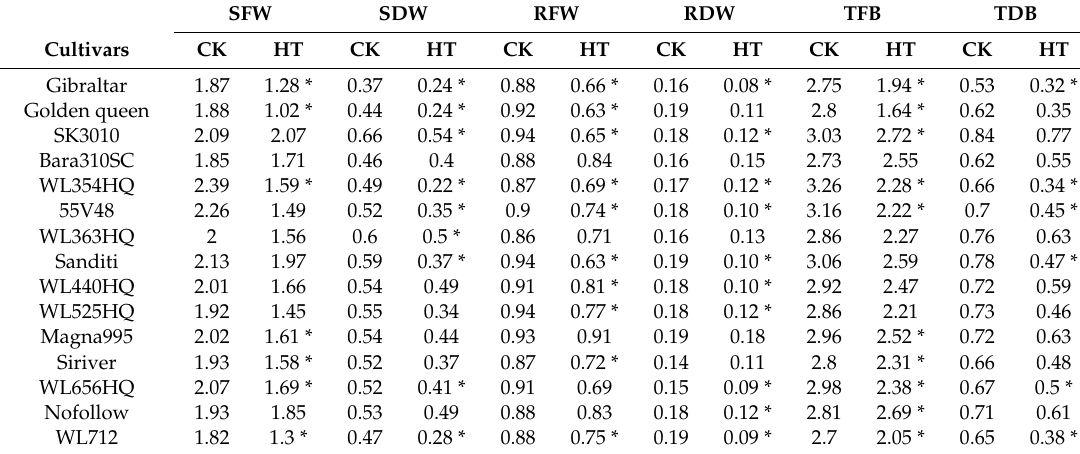
Table 2. E ff ect of heat stress on alfalfa plant biomass